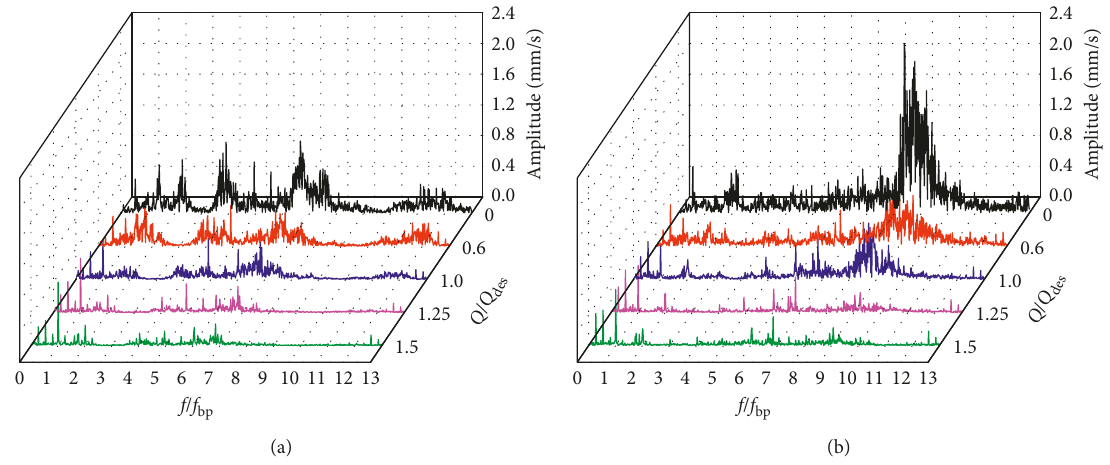
Figure 4: Vibration frequency spectrum at the pump inlet: (a) CH1; (b)